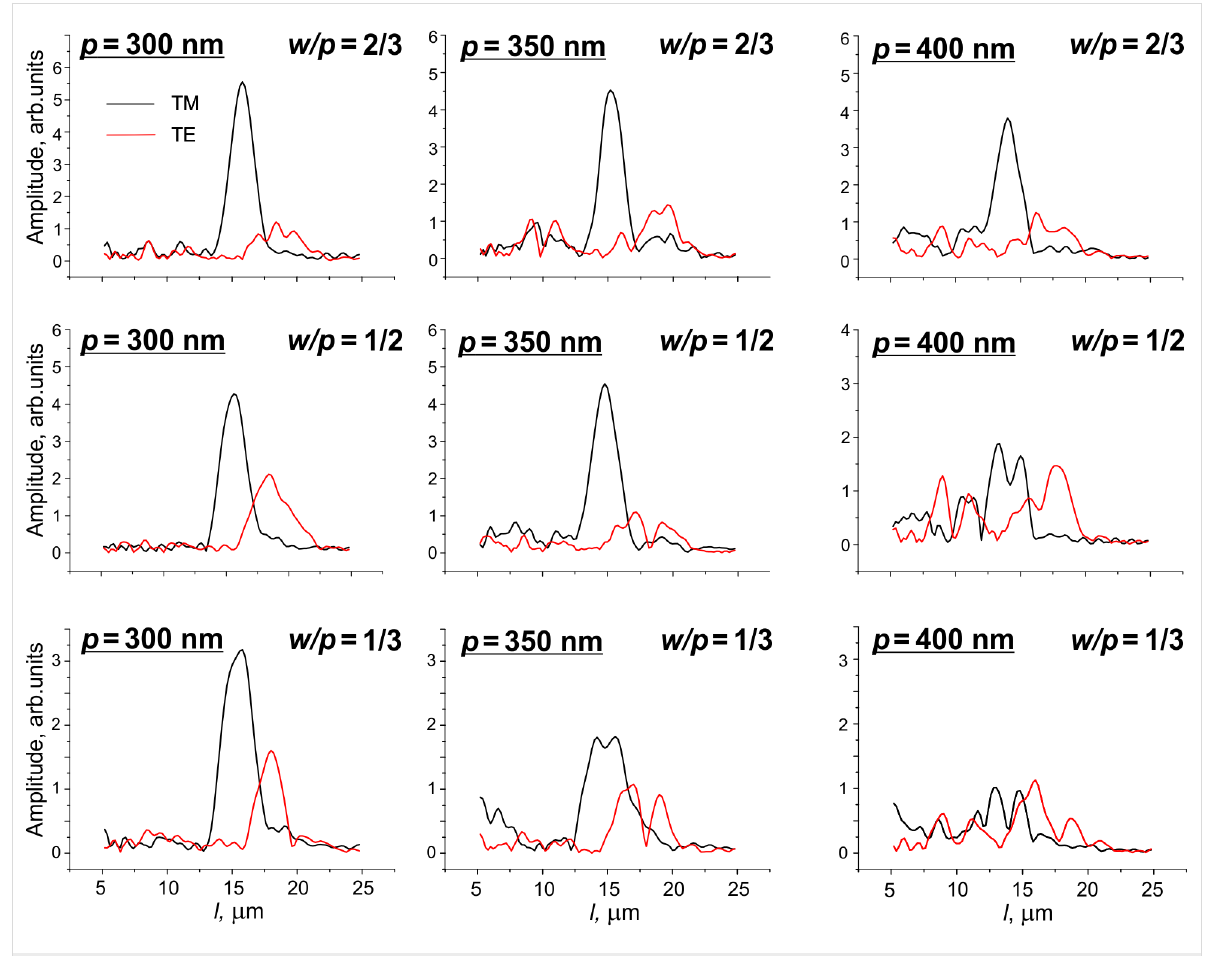
Figure 6: Fourier transform spectra vs grating